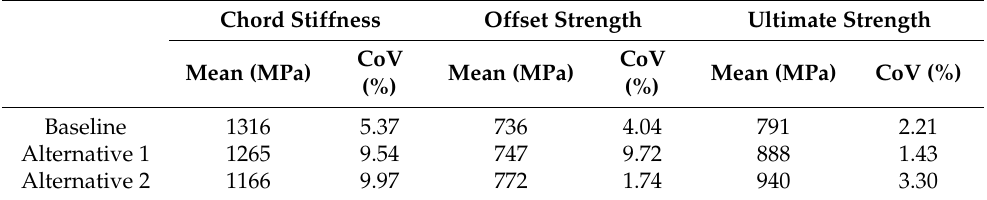
Table 1. Comparison of the bearing chord stiffness, offset strength and ultimate strength of the three configurations. Chord Stiffness Offset Strength Ultimate Strength CoV CoV Mean (MPa) CoV (%) Mean (MPa) Mean (MPa) (%) (%) Baseline